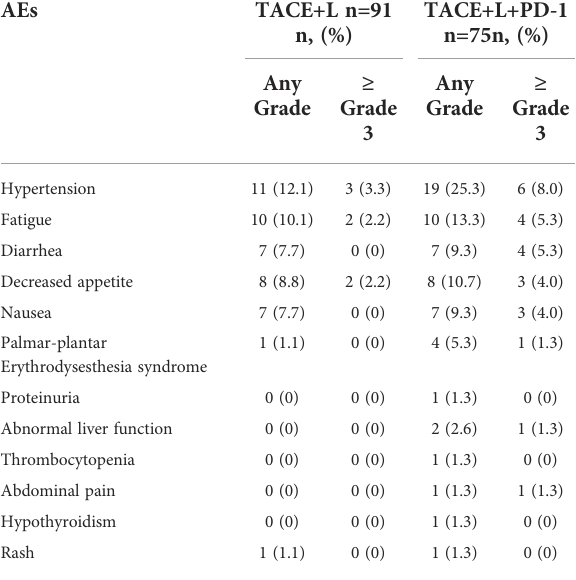
TABLE 3 Treatment-related adverse